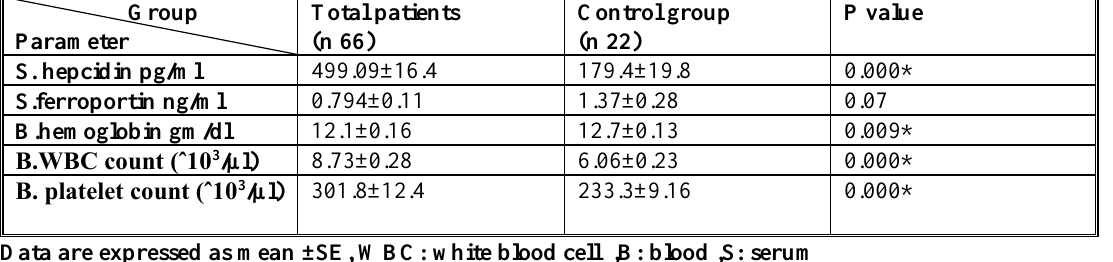
Table6. Blood and serum levels of the studied parameters among the different study groups